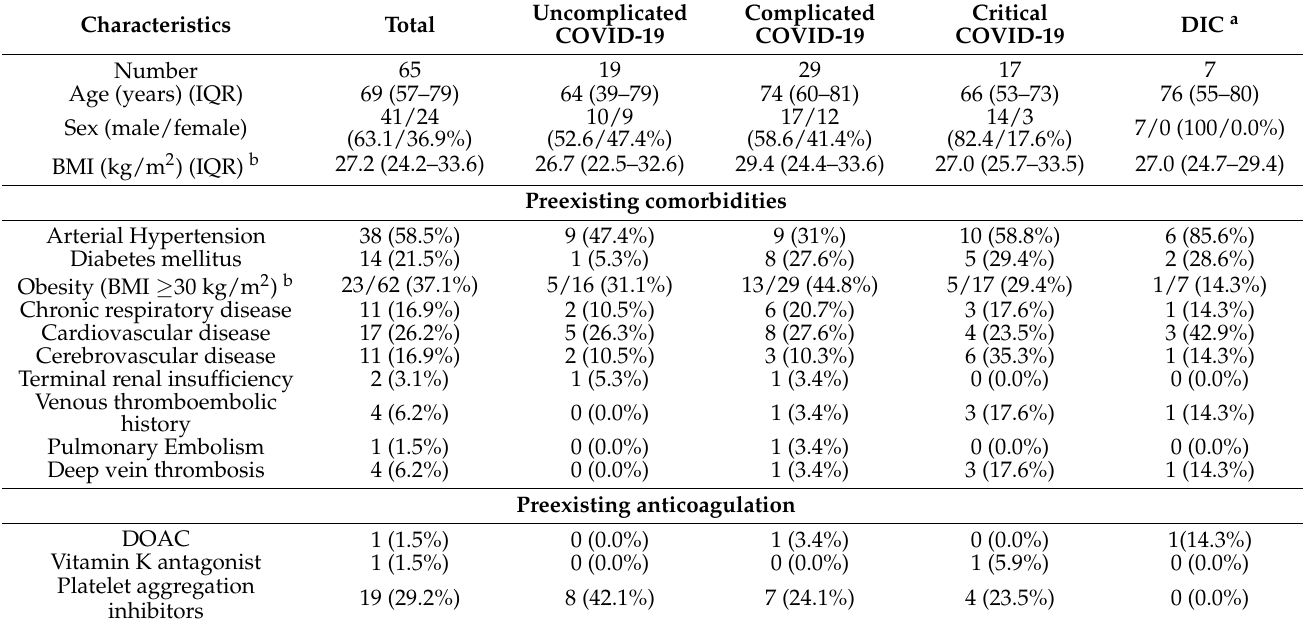
Table 1. Characteristics of 65 patients with COVID-19 and analyzed for haemostatic abnormalities.